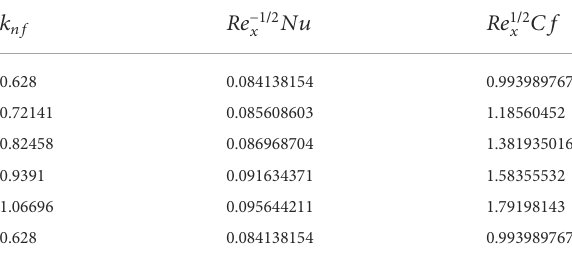
TABLE 5 For nano fl uid with copper oxide nanoparticles with several nanoparticle factors, Nusselt number and local skin friction coef fi cient are equal to